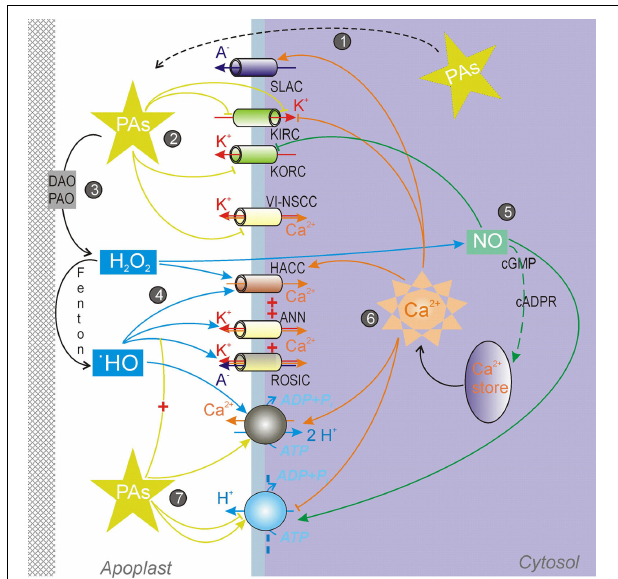
FIGURE 2 | Regulation of ion transport across the plasma membrane by polyamines and their catabolites. (1) PAs are exported from the cytosol to the apoplast against the electrochemical gradient. (2) PAs inhibit K + (inward-rectifying, KIRC and outward rectifying, KORC) and non-selective voltage-independent cation (VI-NSCC) channels. (3) PAs oxidation by diamine (DAO) and/or polyamine (PAO) oxidases